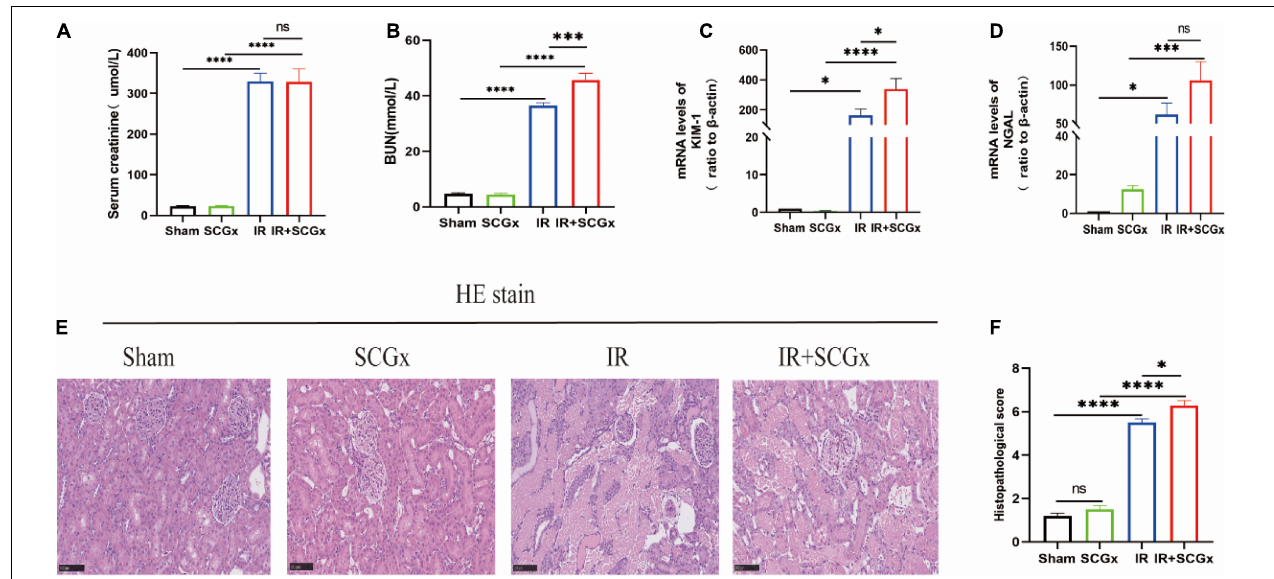
FIGURE 2 | Sympathetic denervation aggravated renal IR injury. (A) The Scr levels. (B) The BUN levels. (C,D) The mRNA levels of KIM-1 and NGAL in kidney. β -actin used as internal control. (E) Representative images of H&E staining in rat kidneys. (F) Histological score from H&E samples ( n = 10). Scale bar = 100 µ m. * P < 0.05; *** P < 0.001; **** P < 0.0001, each group contains at least 4